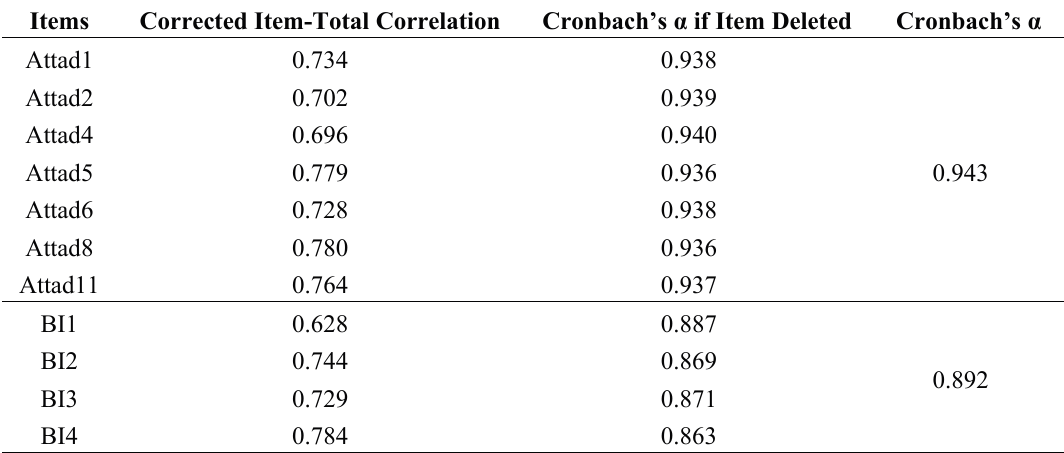
Table 2. Reliability of dependent